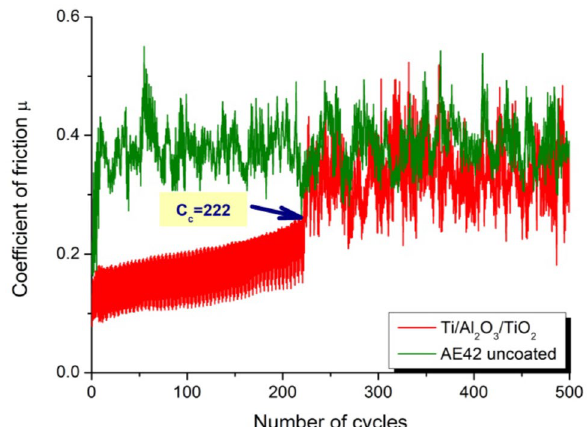
Figure 17. Friction coefficient as a function of the number of cycles for uncoated AE42 alloy substrate material and Ti/Al